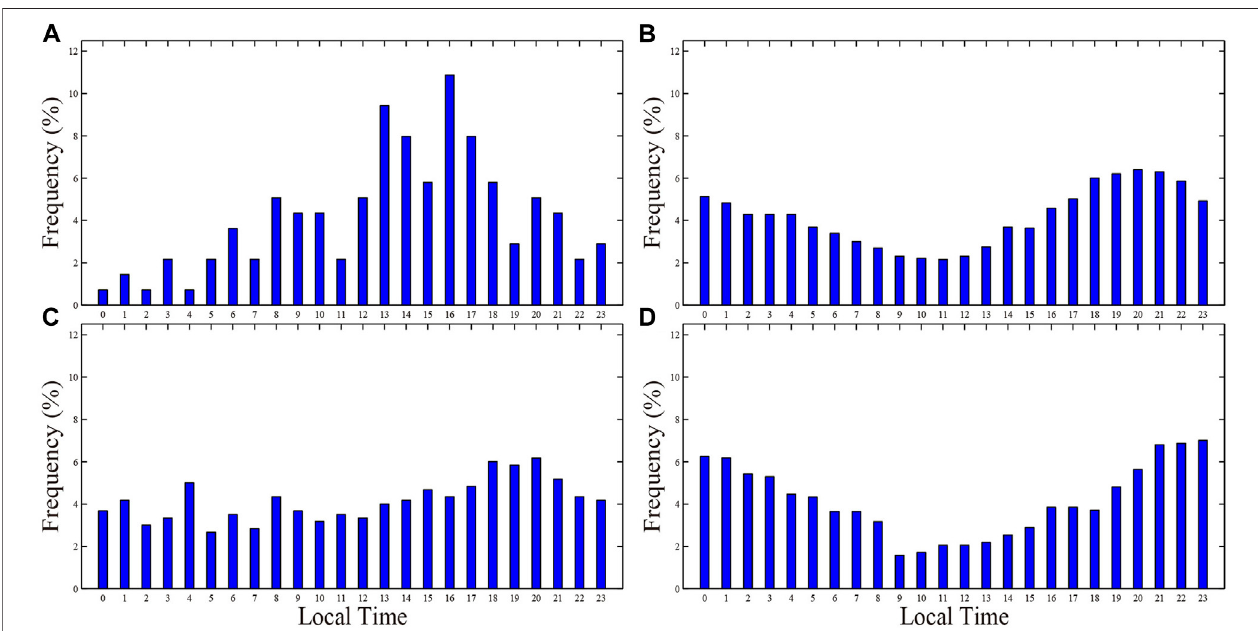
FIGURE 5 | Diurnal variations of HWH frequency at the four stations of (A) Dabancheng, (B) Yiwanquan, (C) Toksun and (D) Aydingkol Lake in southern TGC.